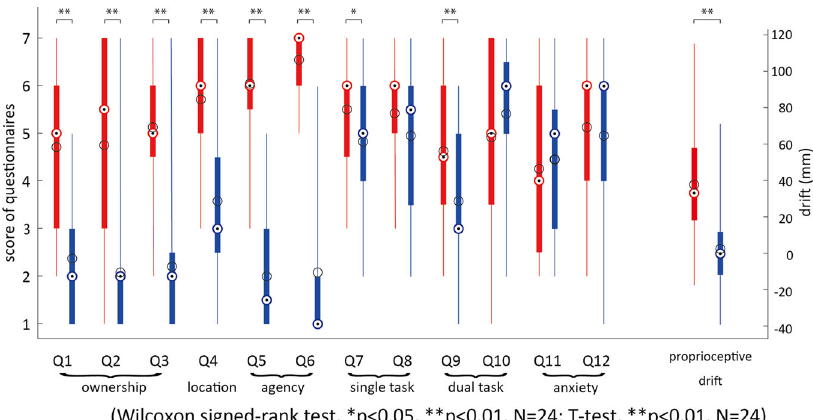
Fig. 2 Embodiment modulation across conditions. The participants scored twelve questions on a Likert scale after the EMB (red plot) and no-EMB (blue plot) conditions. The black circles show the mean and the colored circle with the dot shows the median scores across participants. The box edges show the 25th and 75th percentile of the data and the whiskers show the data range. The questions veri fi ed their subjective perception of ownership, location, the agency of the robot arm, their single- and dual-task performance, and the anxiety during their performance. We considered the average score from their fi rst six questions as the measure of embodiment (the embodiment score) perceived towards the robot hand. We also measured the proprioceptive drift in each